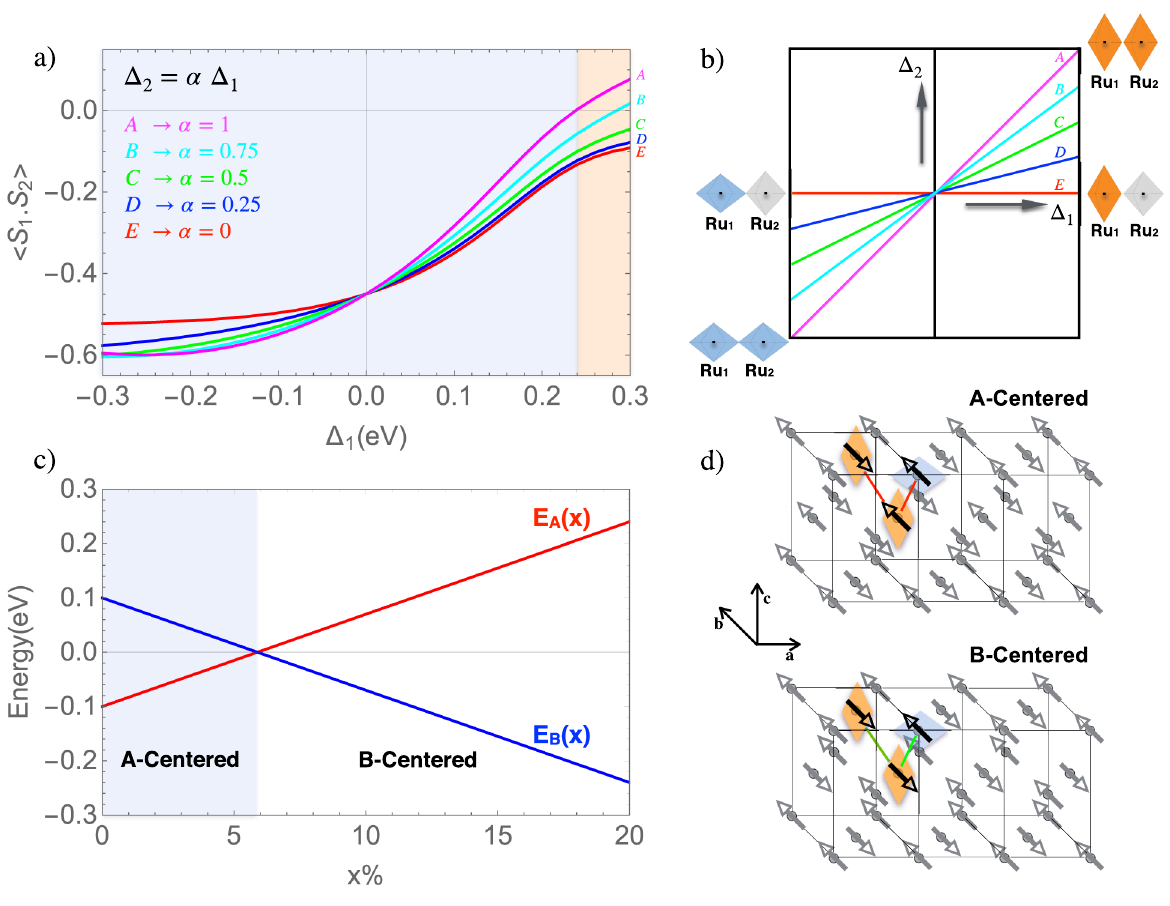
Figure 3. ( a ) Theoretical model calculation of the spatial spin correlations developing among two Ru ions linked along the ( 1 2 , 0, 1 2 ) direction. Different curves refer to different conditions for orbital reconstruction around the Mn-impurity sites, corresponding to several values of the ratio α between the tetragonal crystal field terms (cid:31) 1 and (cid:31) 2 , as depicted in panel ( b ). The orange shaded area corresponds to the region where one gets the changeover form AF to FM bond exchange. Panel ( d ) shows a schematic view of the magnetic patterns A and B, where the orbital reconstruction around the impurity sites induced by d 3 impurity in a d 4 host is highlighted. In particular, Blue (orange) colors indicate compressed (elongated) octahedra respectively. We notice that in the B-centered structure, an FM exchange gain along the ( a , c ) as well as of the AFM exchange gain along the (bcc) (green lined) are allowed. Panel ( c ) shows the comparison of the energies of the A and B phase, as a function of the Mn impurity concentration interaction terms at the ruthenium and oxygen sites and the kinetic term for the ruthenium–oxygen connectivity within the ( a , c ) plane (For details, see Sec. E of the Supplementary Information online 22,23 . As for the effect due to Mn impurities, it is taken into account as follows. Doping with Mn 4 + impurities leads to substitution of d 4 with d 3 configurations, having local S = 3/2 and without an orbital degree of freedom (dou- blon). It has been recently demonstrated that the d 4 – d 3 spin–orbital exchange driven by Coulomb correlations yields an orbital reconstruction around the impurity sites 24,25 . In particular it acts as an effective crystal field potential (cid:31) , which tends to promote the doublon to the ( d zx , , d yz ) sector (see Fig. 3b). In CRO, this impurity exchange tends to compete with the lattice potential, and can even end up reversing the sign of the crystal field interaction. Within this frame, we include in our model an additional effective term, which simulates the inver- sion of the crystal field (CF) at the sites located around the impurity. We investigate the microscopic model by means of exact diagonalization (ED) on a cluster consisting of a Ru–O 2 –O 2 –Ru arrangement of transition metal and oxygen ions, in a fashion which reproduces the connectivity within the ( a , c ) plane. We determine the most favored magnetic exchange via the calculation of the static structure factor (SSF) among the Ru spins, and the way it gets modified by the effect induced by Mn doping on the orbital population at the Ru sites. In Fig. 3 we report the evolution of the SSF as a function of the effective CF terms at the Ru sites (cid:31) 1 and (cid:31) 2 . The parametrization (cid:31) 2 = α� 1 allows to take into account the possibility of inhomogeneous reconstruction of the orbital population on the two sites, as schematically depicted in panel (b). Extreme negative values of (cid:31) 1 cor- responds to the undoped CRO compound where the xy orbital is about fully occupied. The magnetic exchange in this condition is schematized in Fig. 1d, where we show the effective AFM interaction between the Ru magnetic moments, in an orbital configuration where the zx and yz are half filled and form a spin one.